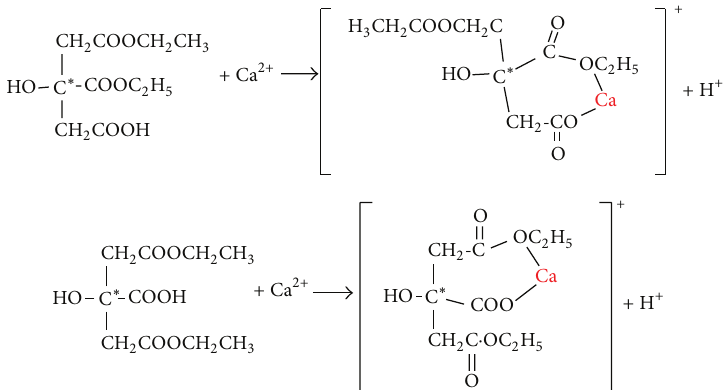
Figure 7: Schematic of the coordination of Ca 2+ ion with two isomers of anticoagulant Et 2 Cit. The asterisk ∗ shows the center C atom of Et 2